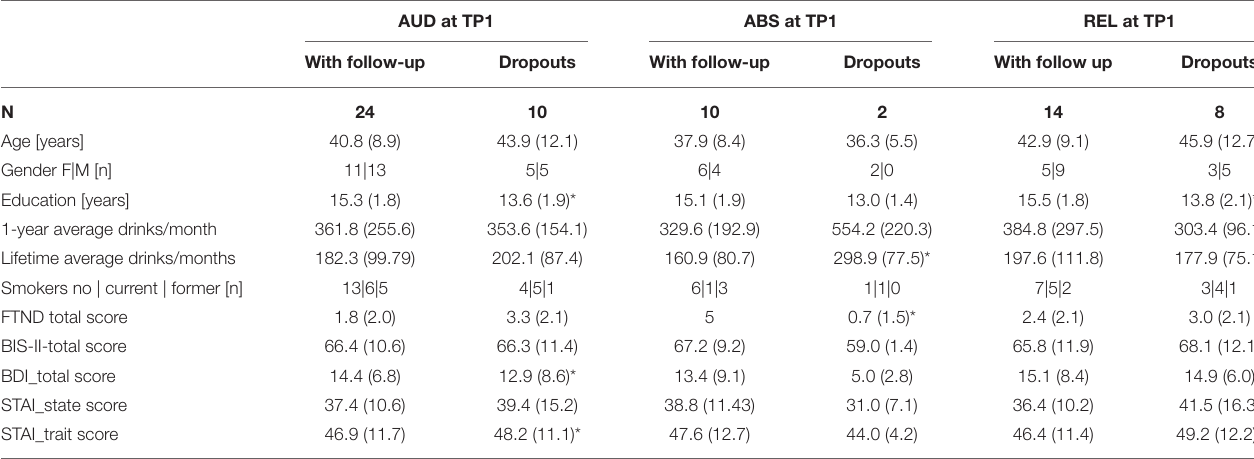
TABLE 1b | Comparison of participants with and without follow-up. AUD at TP1 ABS at TP1 With